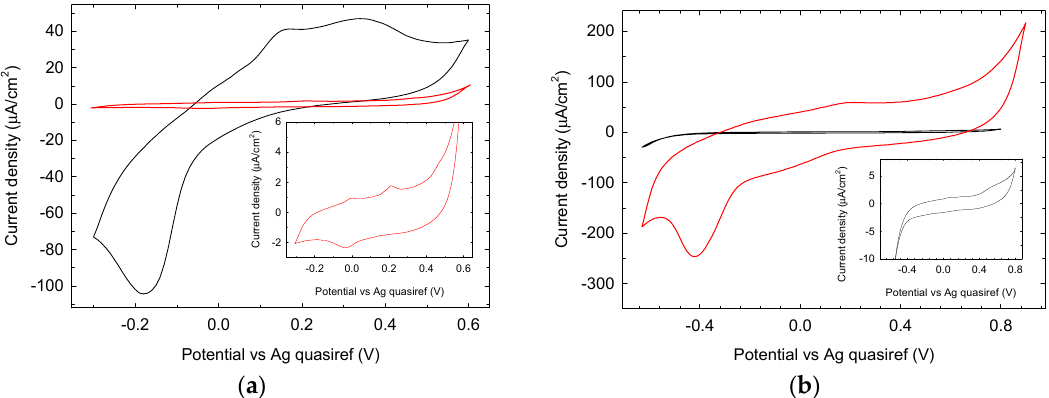
Figure 11. Cyclic voltammetry at ( a ) an untreated (black trace) and LIFT treated with 0.1 M phosphate buffer (red trace and inset) Au SPE and ( b ) an untreated (black trace and inset) and LIFT treated with 0.1 M phosphate buffer (red trace) GC SPE driven in phosphate buffer 90 mM pH 7.0, scan rate 50 mV/s.